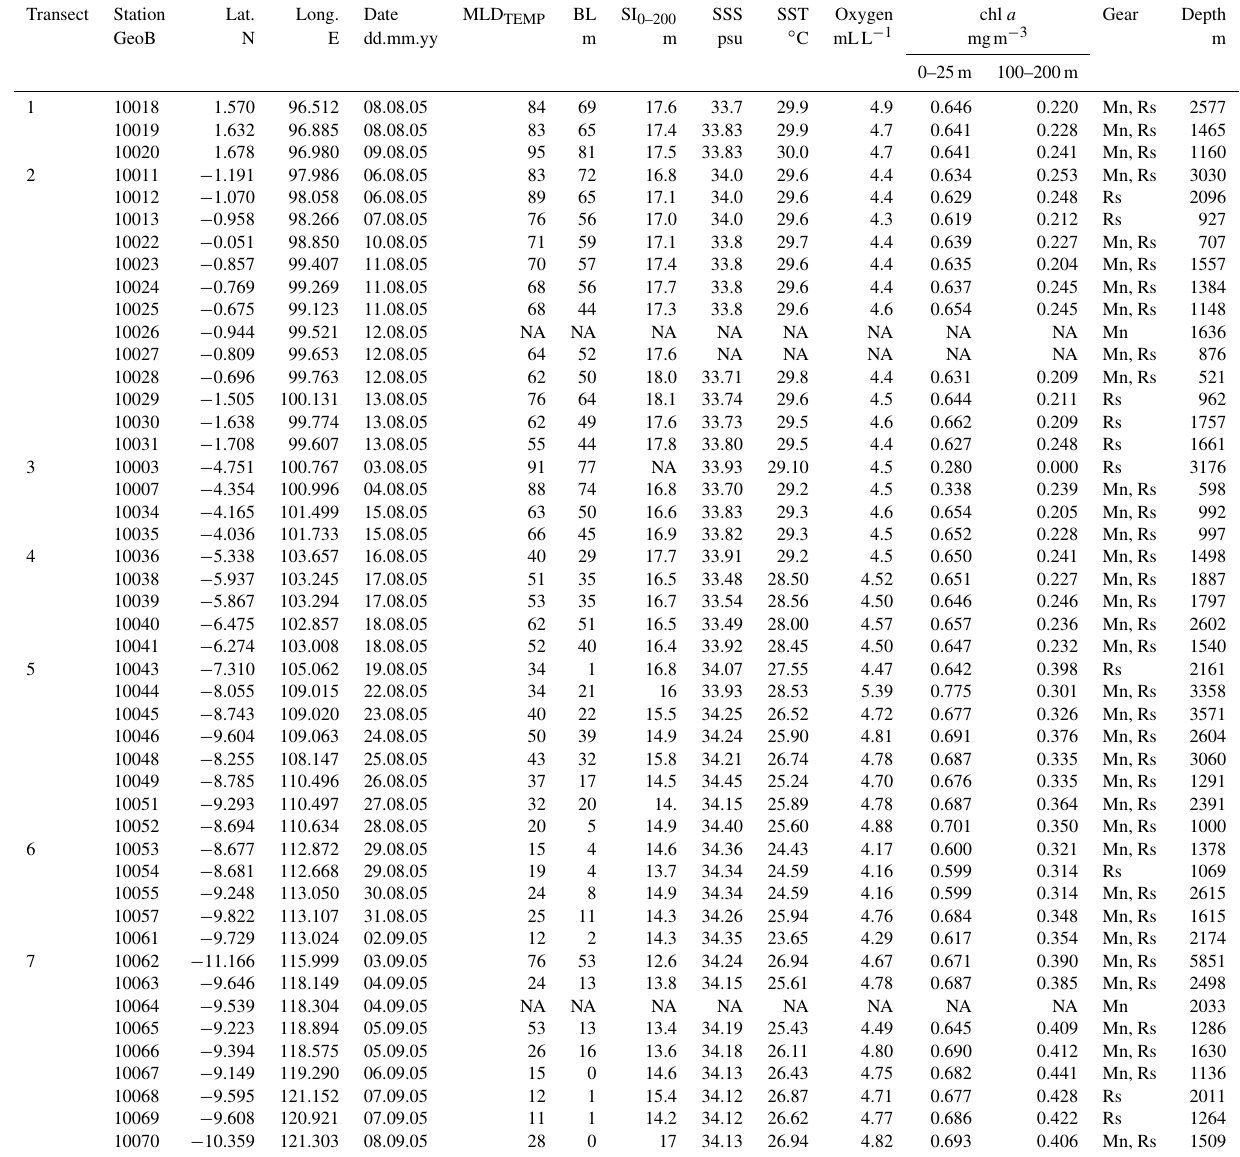
Table A1. Details of the plankton net stations (location, water depth, and sampling date) during cruise SO-184 (Hebbeln and cruise par- ticipants, 2006). The stations are divided into seven transects. Relevant environmental parameters during the sampling include the thermal mixed-layer depth (MLD TEMP ), barrier layer thickness (BL), stratification index (SI 0–200 ), observed sea surface temperature (SST), sea surface salinity (SSS), and in situ chlorophyll a (chl a ) at the surface (0–25m) and thermocline level (100–200m) (Table 5.1 in Hebbeln and cruise participants, 2006). Sampling gear: MultiNet (Mn), rosette sampler (Rs). NA: no data available.